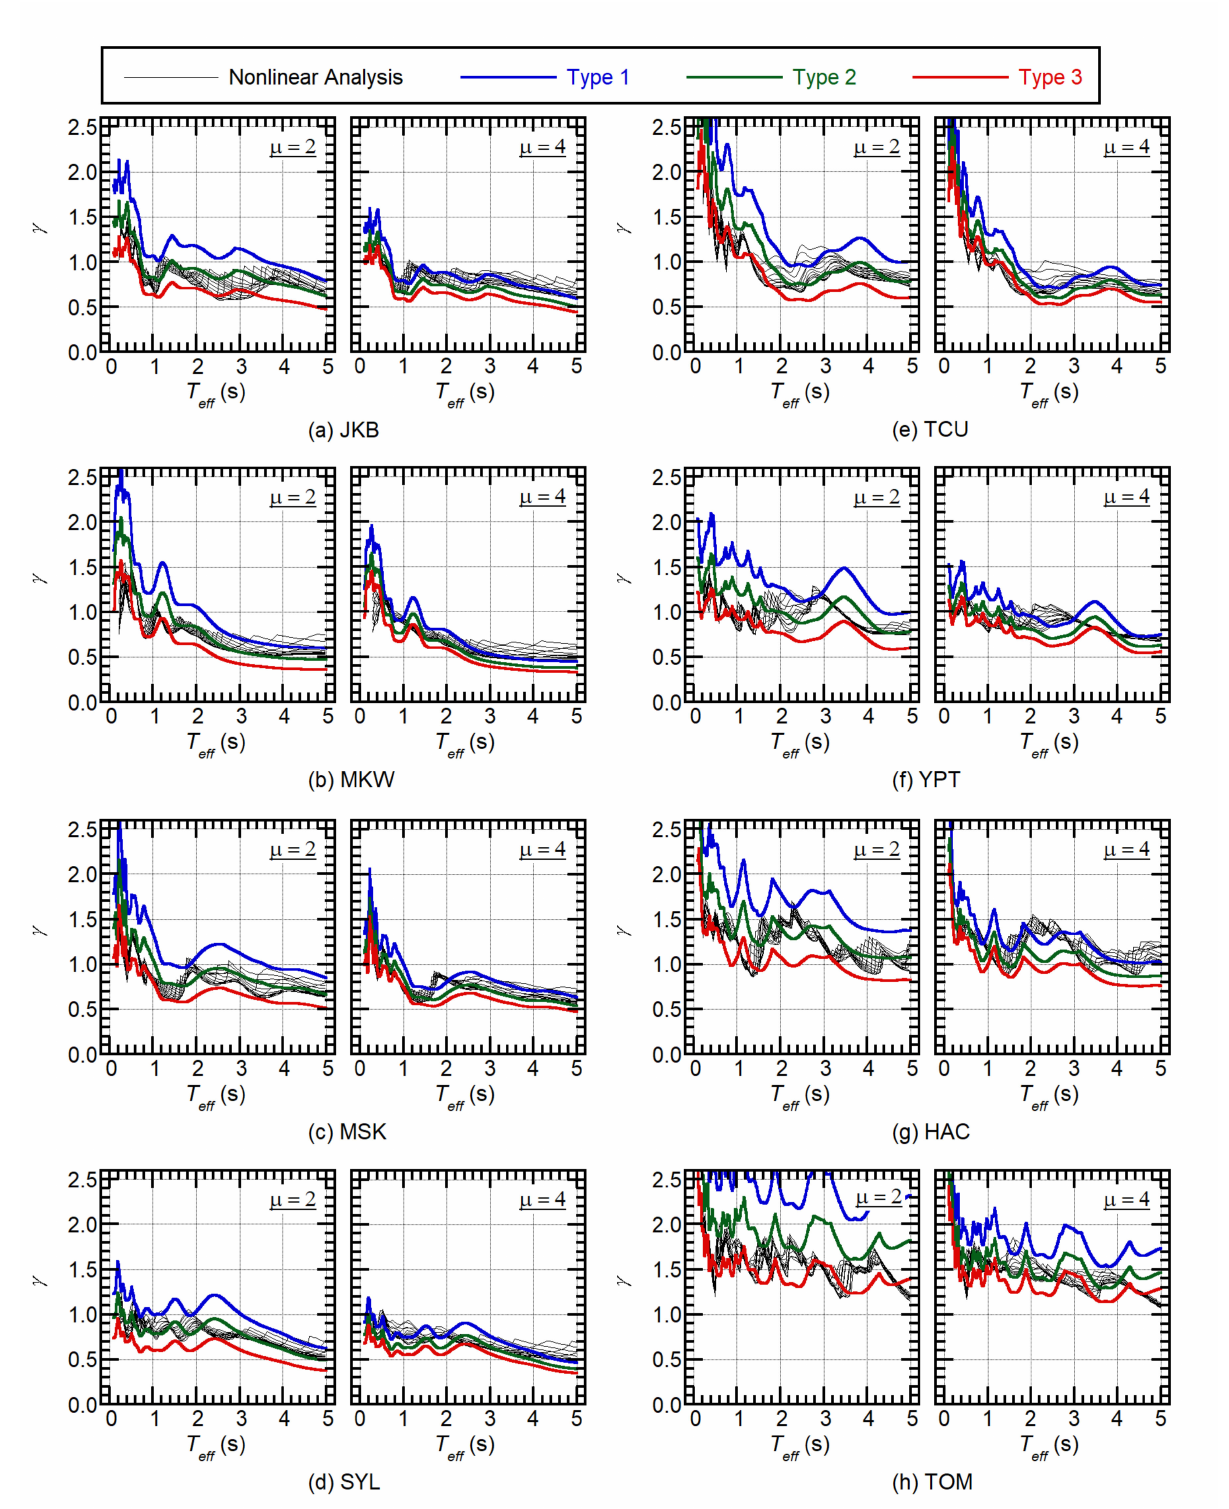
Figure 10. Evaluation of dimensionless parameter γ for each ground acceleration